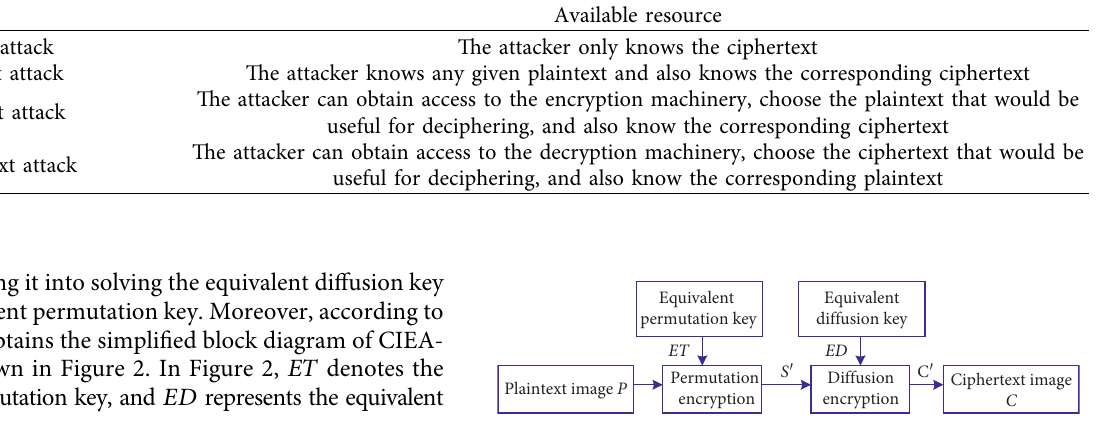
Figure 2: Simplified block diagram of